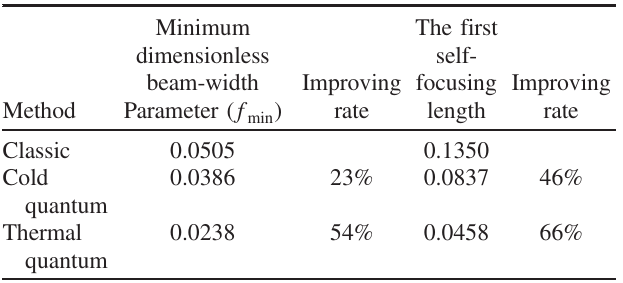
TABLE I. The minimum dimensionless beamwidth parameter and the first self-focusing length obtained by considering the thermal and cold quantum models are compared with the ones given by the classical method in Fig.